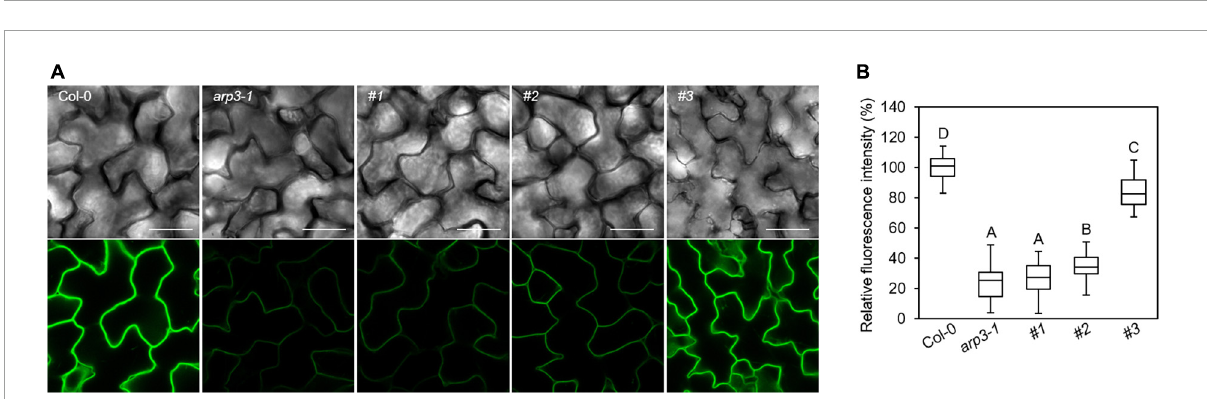
FIGURE2 Clustered regularly interspaced short palindromic repeats (CRISPR)-derived gene variants of ARP2 exhibit different levels of GFP-PEN1 in leaf epidermal cells. (A) Representative confocal images of GFP-PEN1 signals in the epidermal cells of the first true leaves of 2-week-old wild-type Col-0 , arp3-1 T-DNA mutant line, and T1 generation of CRISPR transgenic individual lines #1, #2, and #3 in GFP-PEN1 expressing plants. Micrographs were captured with the same imaging parameters. Bars, 100 µ m. (B) Boxplots displaying relative fluorescence intensity of GFP-PEN1 at the plasma membrane in the indicated genotypes. Quantitative analysis was performed for 30 cells per genotype. Different letters indicate statistically significant differences, as determined by one-way ANOVA with Tukey’s HSD ( p < 0.01).